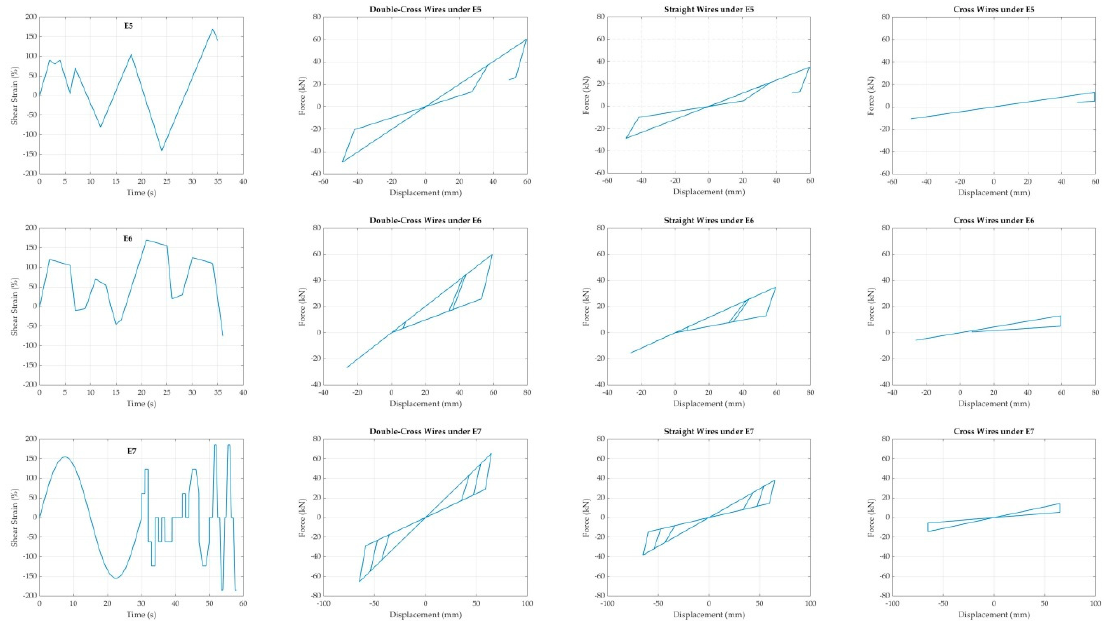
Figure 9. Excitations (E5, E6 and E7) in terms of shear strain versus time, and corresponding shear hysteresis responses of the three SMA wire configurations in terms of force versus displacement.